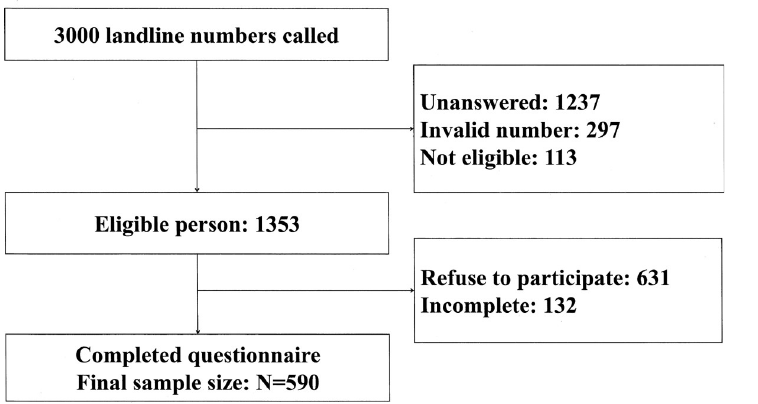
Fig 1. The recruitment details in the telephone